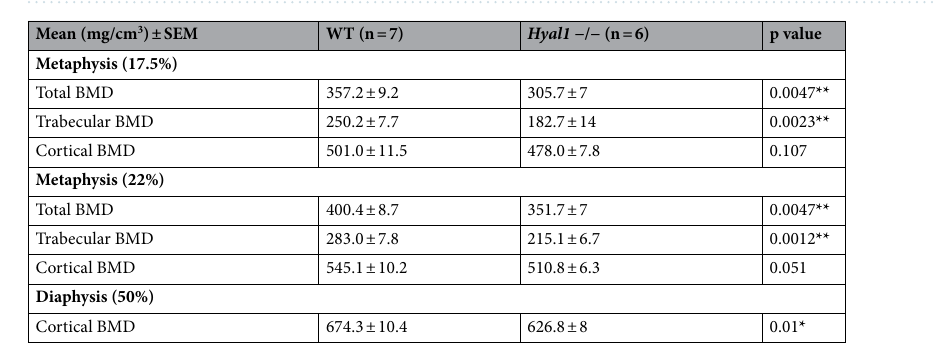
Figure 3. HA accumulates in the femurs of Hyal1 −/− mice. ( a ) Histological sections of WT and Hyal1 −/− femurs were stained for HA using a biotinylated HABP followed by incubation with streptavidin HRP and DAB (3,3 ʹ -diaminobenzidine) oxidation. Tissue sections were counterstained with hemalun. Inlets show zoomed areas ( b ) The extent of the HA staining was quantified and expressed as a percentage of the total area (in n ≥ 8 mice for each group). The graph shows the means ± SEM. **p < 0.01 (two-tailed Mann–Whitney U test).